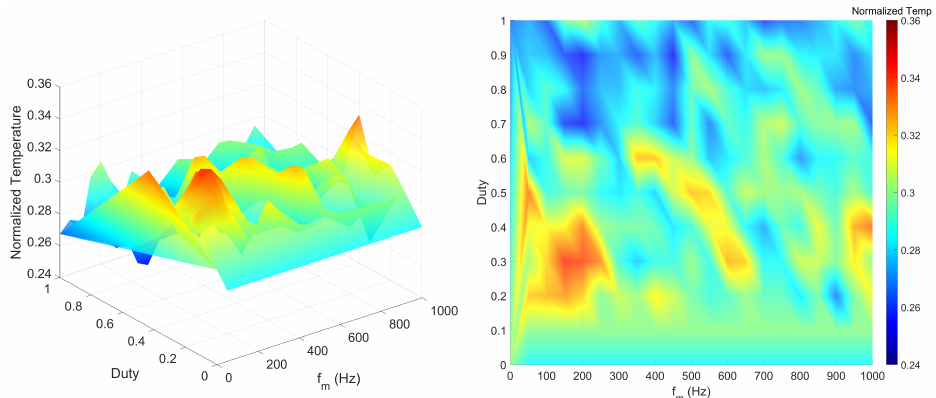
Figure 19. Surface plot and heat scatter plot ( f m vs. duty vs. Normalized Temperature) while θ = 0 at centerline where x / h =